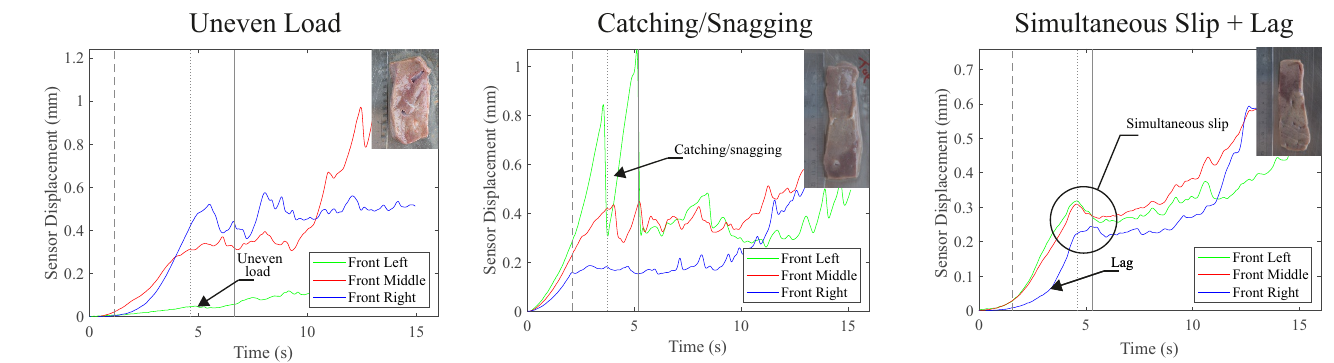
Figure 9. Graphs showing sensor displacements for cases in which early slip detection was unsuc- cessful or there were abnormal sensor responses for liver tissue retractions.